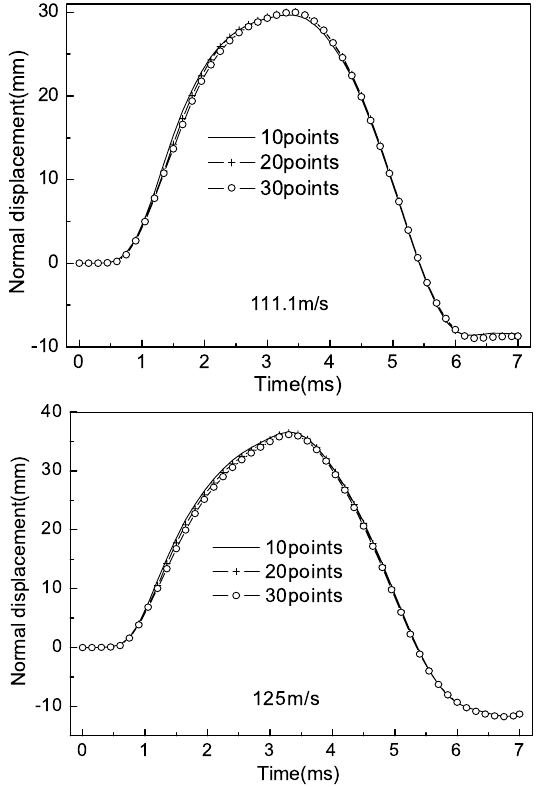
Fig. 14. Time history of normal displacement at the center on inner surface for different mesh seeds along central axis of bird. Fig. 24. It can be seen that framework, arc-frame and gasket influence greatly on kinetic energy and total